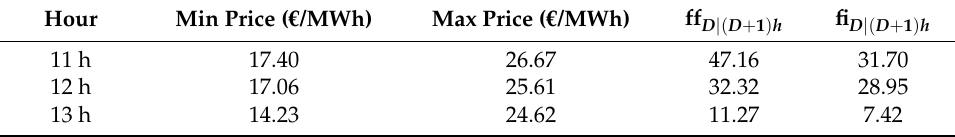
Table 5. Results of PPFMCP model 3.